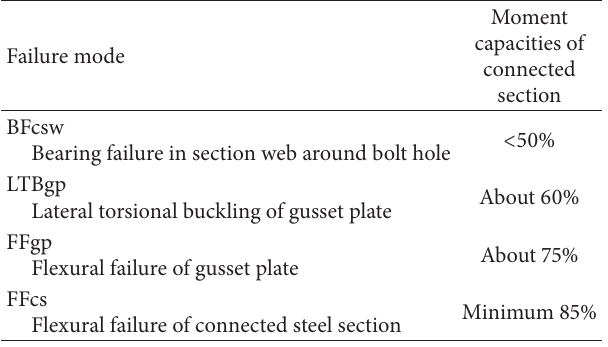
Table 1: Different failure modes to predict the joint strength and stiffness.